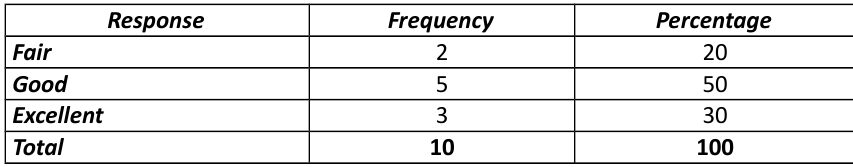
Table 4. Teacher’s personal level of knowledge in